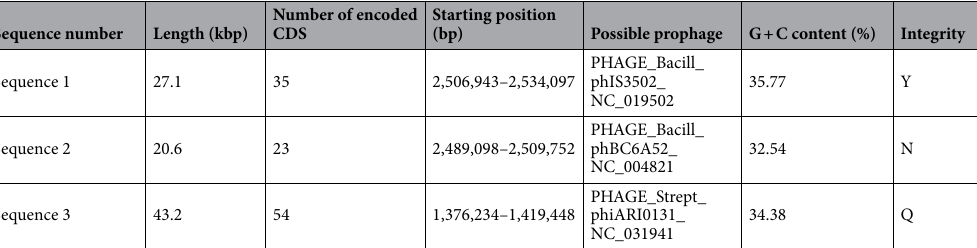
Number of encoded Starting position CDS (bp) Possible prophage G + C content (%) Integrity